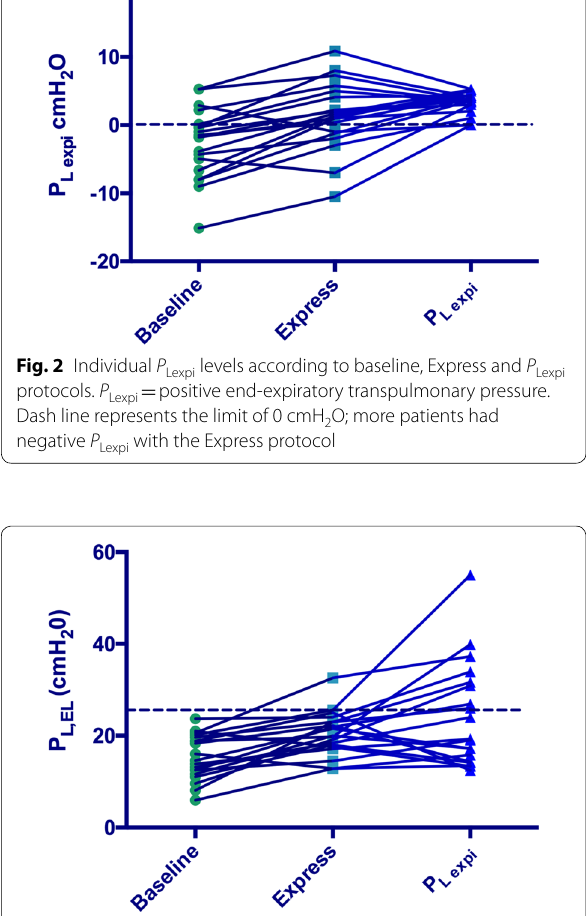
Fig. 3 Individual P L,EL with baseline, Express and P Lexpi protocols.